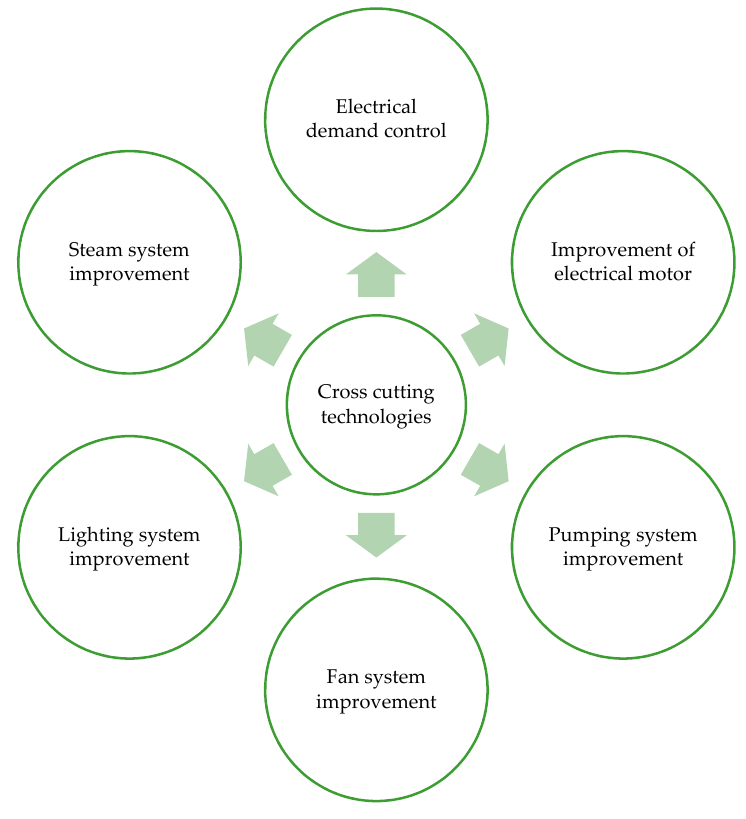
Figure 4. Cross-cutting energy efficiency measures [37,43].